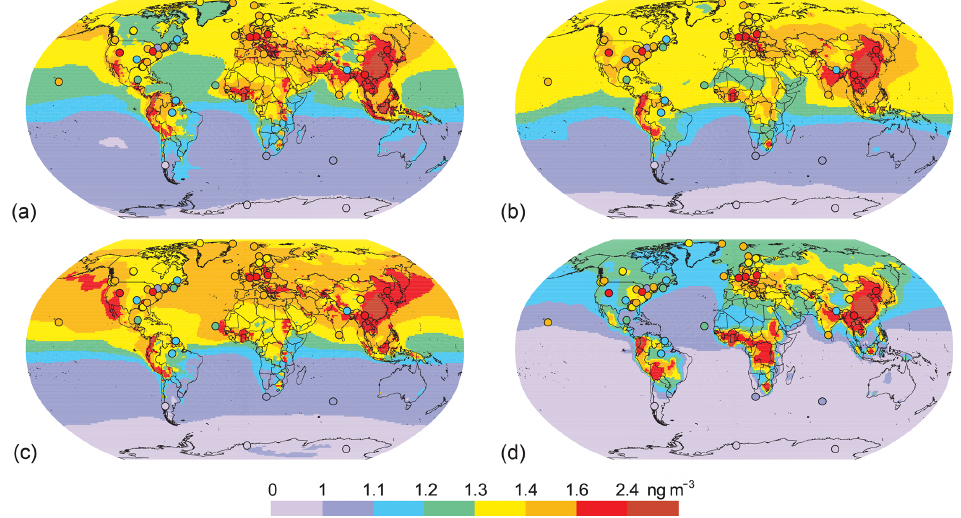
Figure 2. Spatial distribution of GEM air concentration in 2013 simulated according to the BASE case by four global models: (a) GLEMOS, (b) GEOS-Chem, (c) GEM-MACH-Hg, and (d) ECHMERIT. Circles show observed values in the same color